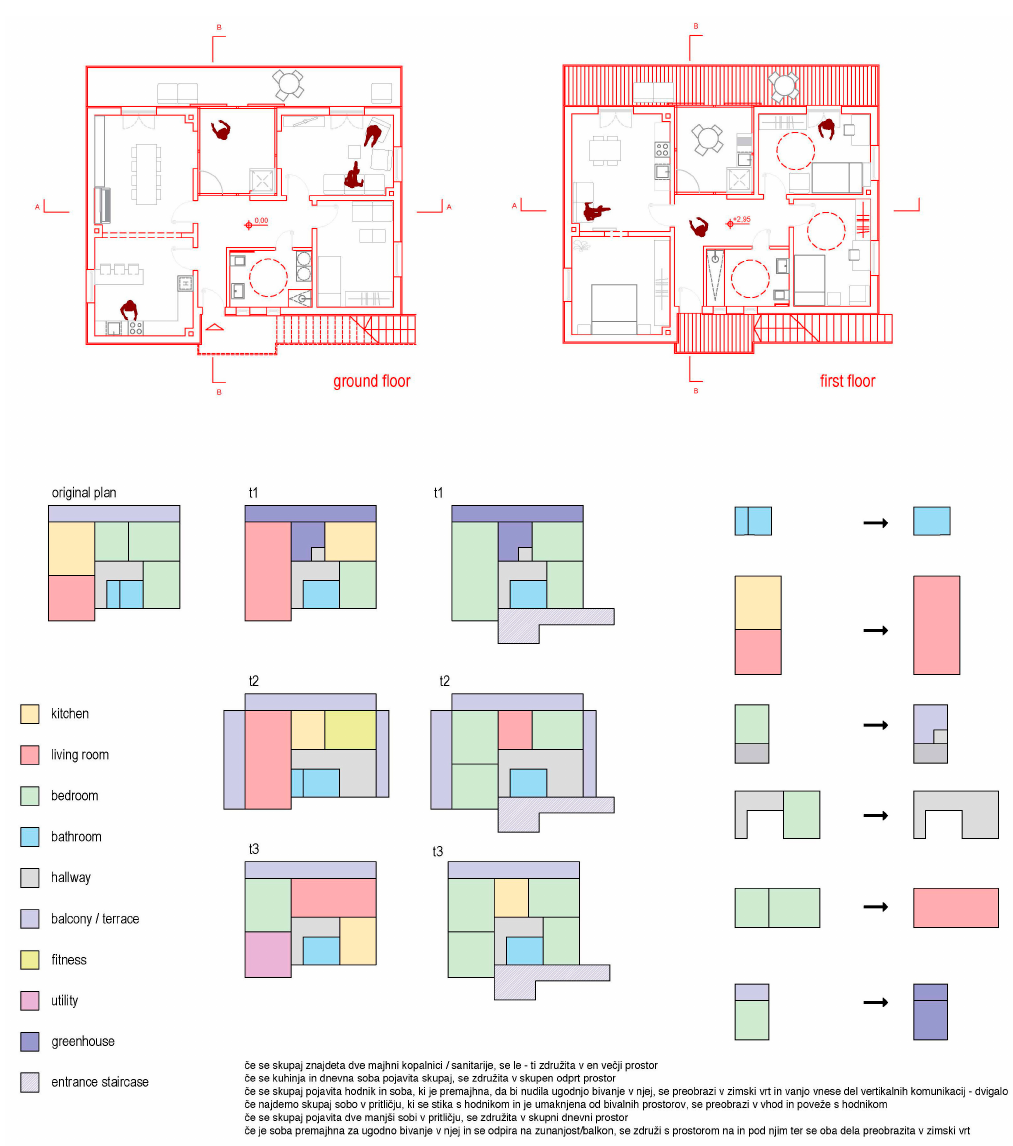
Figure 5. An example of the shape grammars developed by the students. Authors: attendees of Student Workshop 2, 2022.